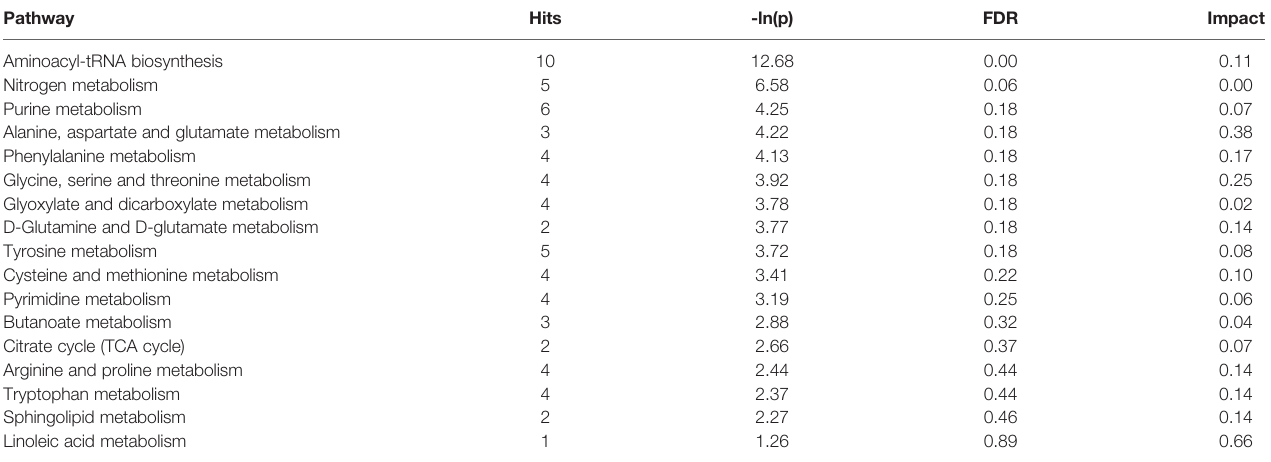
FDR, P value adjusted by false discovery rate; Hits, the matched number of metabolites in a pathway; Impact value, value calculated from pathway topography analysis.